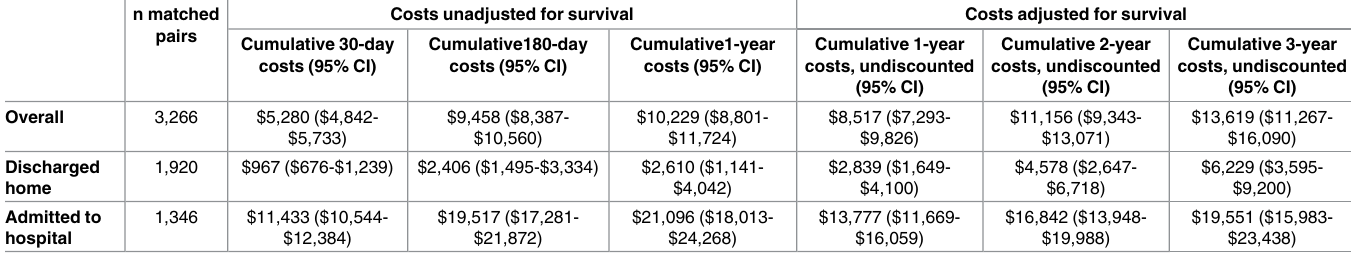
Table 4. Stratified mean attributable costs per subject among those that had their first healthcare encounter as an ED visit. n matched